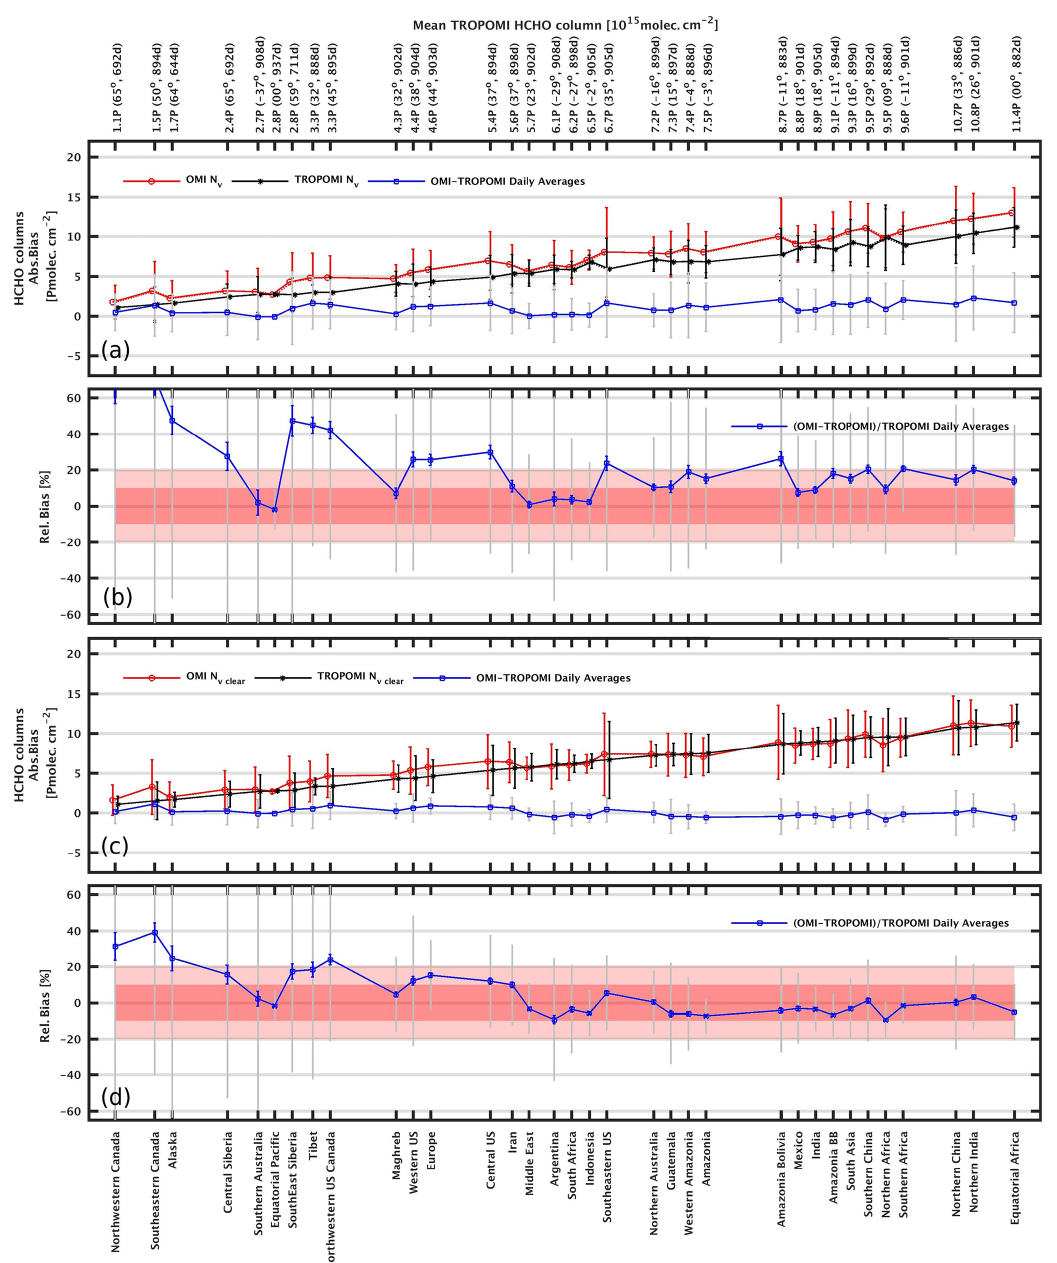
Figure 7. Absolute and relative biases between OMI and TROPOMI HCHO daily averaged tropospheric columns using cloud-corrected AMF ( N v , a, b ) or clear-sky AMF ( N v_clear , c, d ) for the large regions represented on Fig. 5. Regions are sorted as a function of the median TROPOMI HCHO column. Values of the averaged HCHO columns are provided on the top axis as are the numbers of common days taken for the comparison and the latitude of the region. The median OMI (red) and TROPOMI (black) columns are plotted together with the absolute differences (in blue). Error bars represent the median deviations of the columns or the median absolute deviations of the differences (MAD, in grey). Statistical ErrB is also plotted for the relative bias (in blue). Pink areas indicate 10% and 20% bias. (Pmolec.cm − 2 = 1 × 10 15 molec.cm − 2